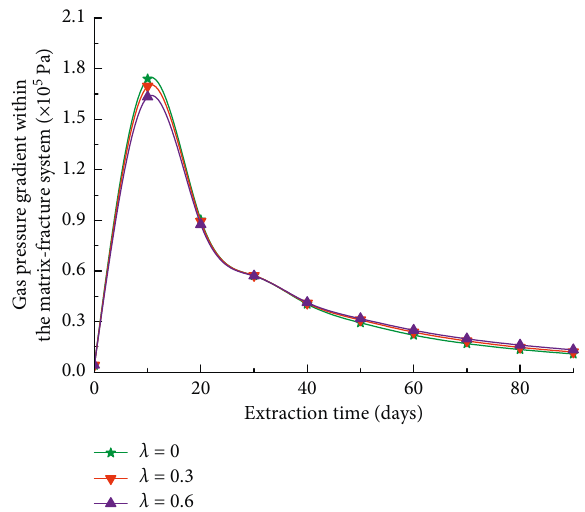
Figure 7: Gas pressure gradient within the matrix-fracture system.